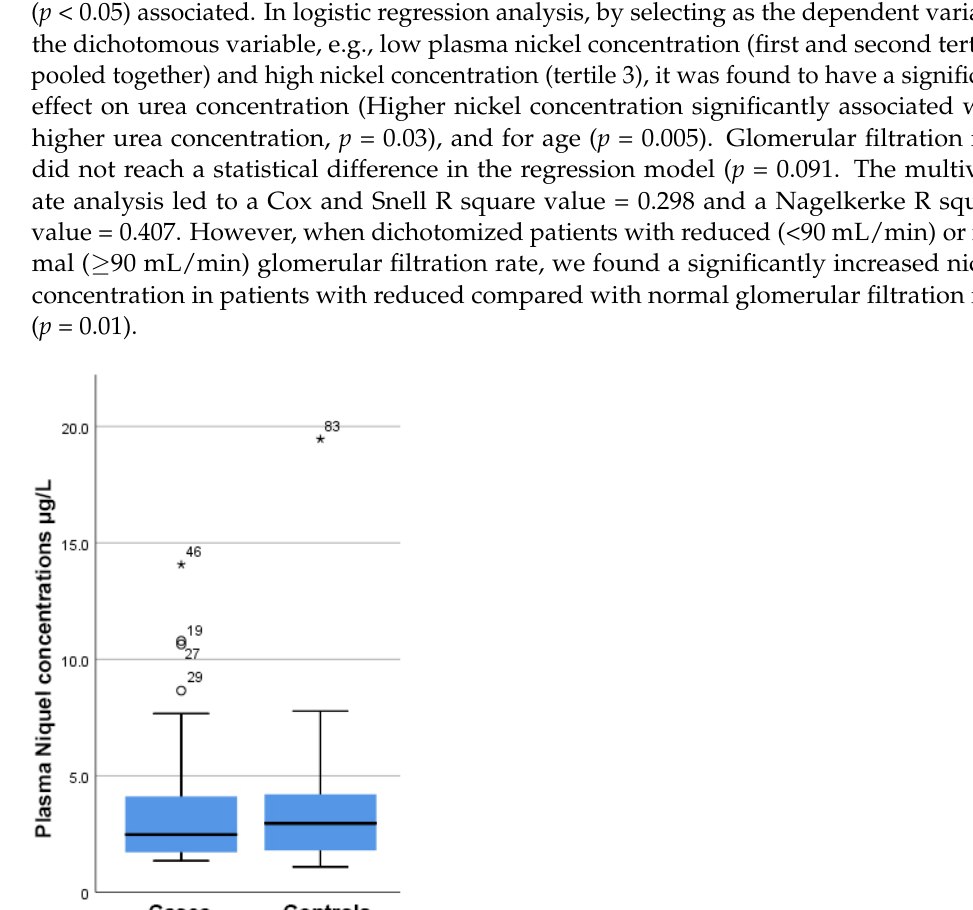
Figure 1. Boxplot showing that there were no differences in the plasma nickel concentration between cases and controls. On the boxplot shown here outliers are identified ("out" values (small circle) and "far out" and "Extreme values" (marked with a star)). Three extreme outliers were removed to improve the fitting.